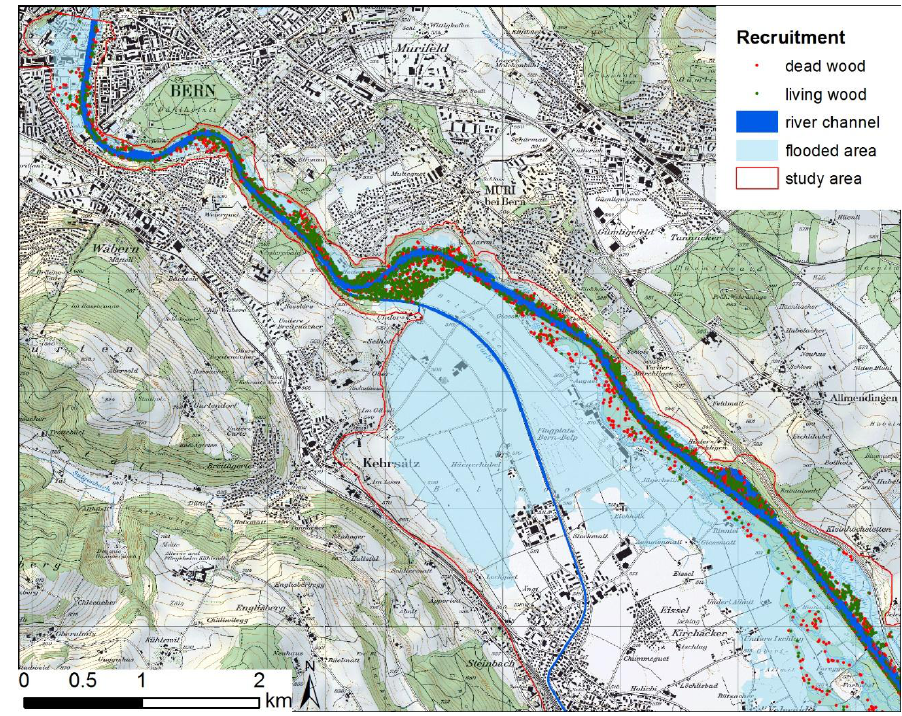
Figure 6. Extract of the map of the recruitment areas of LW that reached the lower system boundary at Bern during the simulation. The dots show the initial locations of the wood logs. Background map: Federal Office of Topography SWISSTOPO. Water 2018 , 10 , x FOR PEER REVIEW